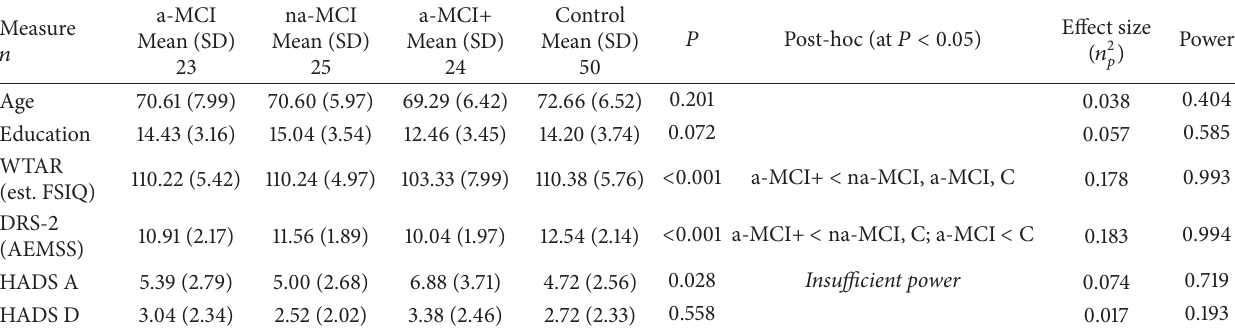
Table 2: Group differences in Age, Education, Estimated Premorbid FSIQ, DRS-2, and HADS scores.